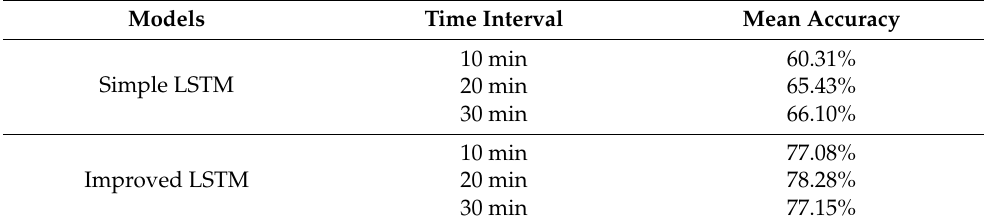
Table 4. The comparison with simple LSTM and improved LSTM.